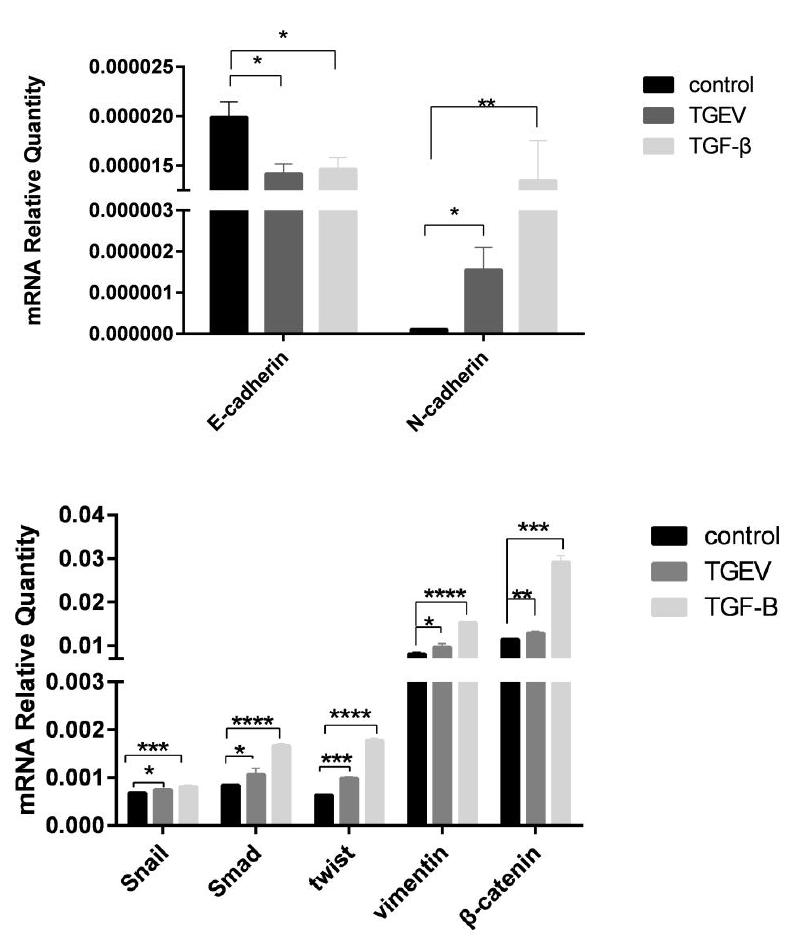
Figure 3. qPCR was used to assess the mRNA expression levels of interstitial markers, including N-cadherin, β -catenin, Smad, Twist, snail and vimentin, and epithelial markers E-cadherin. * p < 0.05, ** p < 0.01, *** p < 0.001, **** p < 0.0001.